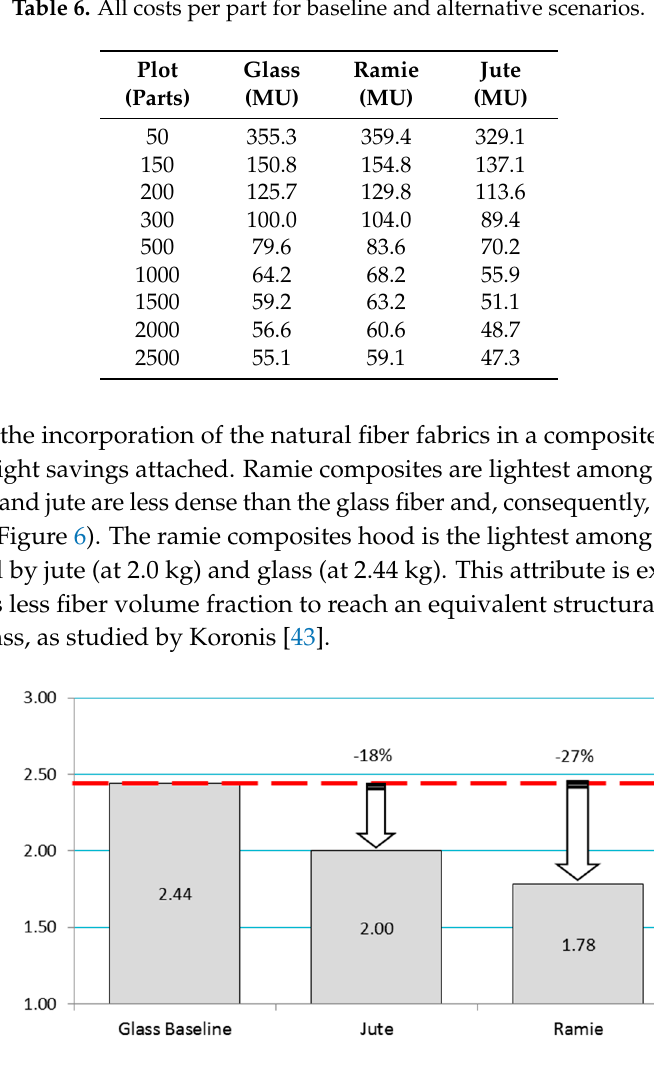
Table 6. All costs per part for baseline and alternative scenarios.